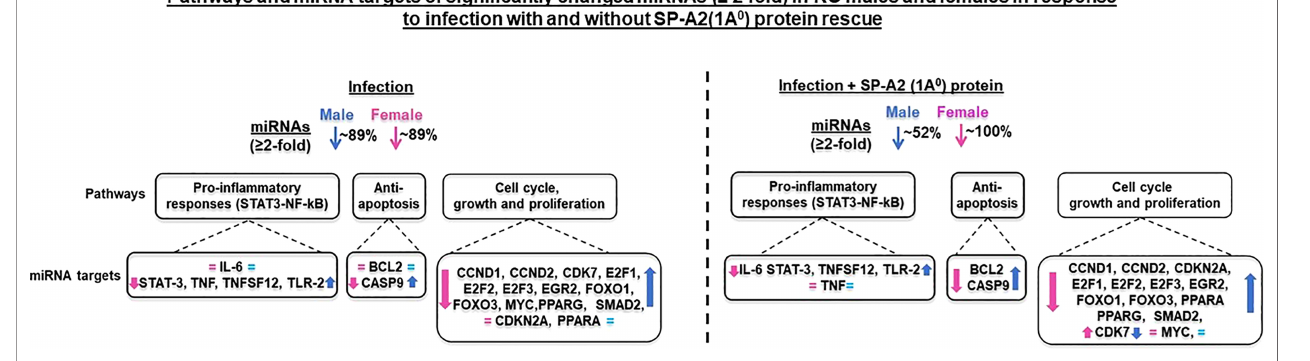
TABLE 1 | LAC KO miRNA levels in male and female mice and their mRNA targets after infection and infection plus SP-A2 (1A 0 ) rescue. miRNA ID Infection Infection + SP-A2 (1A 0 ) Protein # Target molecule Fold change Male mice Female mice Male mice Female mice